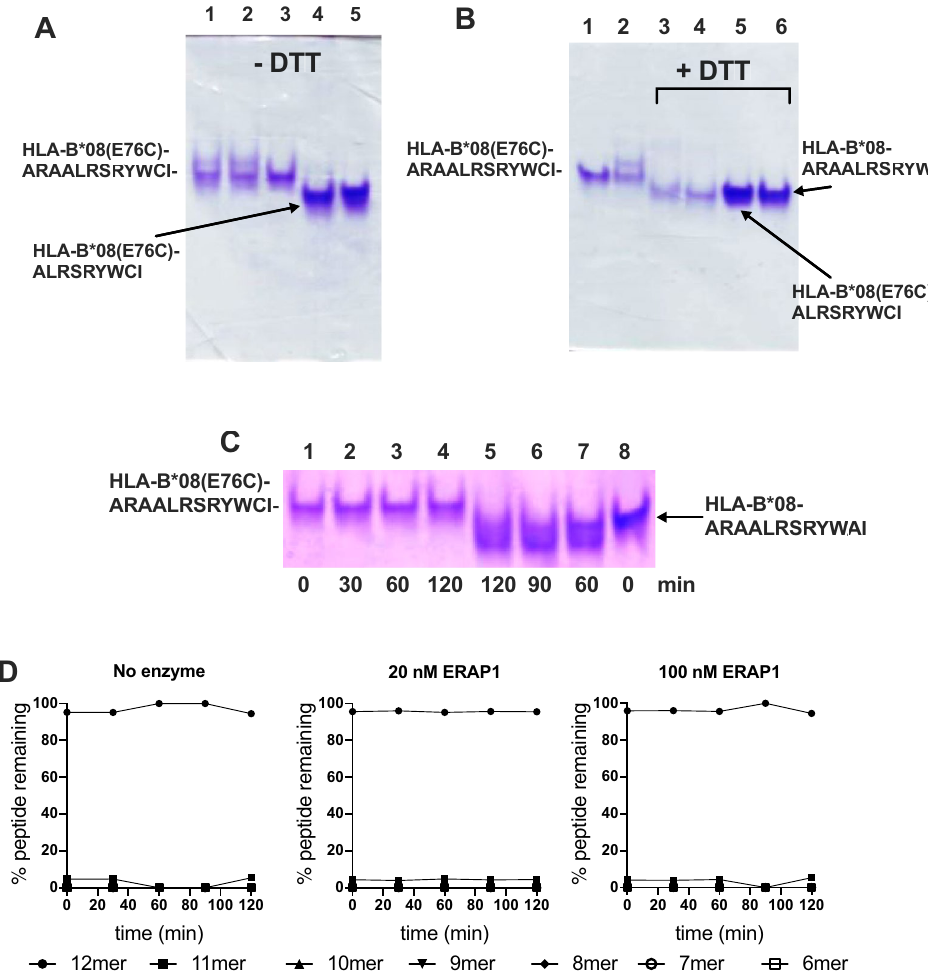
Figure 2. Stability of HLA-B*08(E76C)-ARAALRSRYWCI versus peptide exchange and ERAP1 trimming. Panel ( A ) Νative-PAGE of HLA-B*08(E76C)-ARAALRSRYWCI mixed with excess ALRSRYWAI peptide: lane 1 , complex incubated for 60 min at RT; lane 2 , complex incubated with 100 μΜ ALRSRYWAI peptide for 60 min at RT; lane 3 , complex without incubation; lane 4 , HLA-B*08(E76C)-ALRSRYWCI complex; lane 5 , HLA-B*08-ARAALRSRYWAI complex. Panel ( B ) lane 1, HLA-B*08(E76C)-ARAALRSRYWCI complex incubated at RT for 60 min; lane 2 , HLA-B*08(E76C)-ARAALRSRYWCI complex + 100 μΜ ALRSRYWAI peptide, 60 min incubation; lane 3 , HLA-B*08(E76C)-ARAALRSRYWCI + 100 μΜ DTT, 60 min incubation; lane 4 , HLA-B*08(E76C)-ARAALRSRYWCI + 100 μΜ DTT + 100 μΜ ALRSRYWAI peptide; lane 5 , HLA- B*08(E76C)-ALRSRYWCI; lane 6, HLA-B*08-ARAALRSRYWAI. Panel ( C ) Native PAGE of HLA-B*08(E76C)- ARAALRSRYWCI (lanes 1–4) or HLA-B*08-ARAALRSRYWAI (lanes 5–8) complexes incubated for 0–120 min with 20 nM ERAP1 (full-length gel is presented in Supplementary Fig. 1). Panel ( D ) MALDI-TOF–MS analysis of the HLA-B*08(E76C)-ARAALRSRYWCI complex incubated with